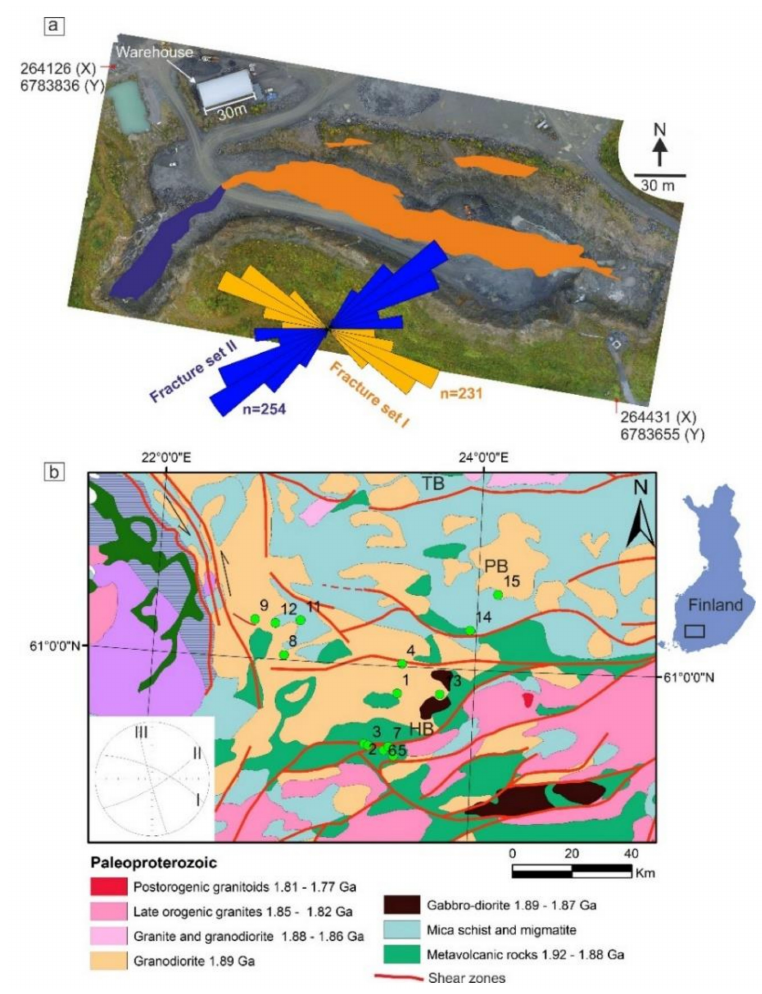
Figure 8. ( a ) Surface resource model of the open-pit mine showing a good match with the strikes of fracture sets I and II. ( b ) Map showing the regional pattern of major shear zones (after [27,30]) and locations of various gold deposits and prospects in SW Finland: (1) Kedonojankulma, (2) Kivenkorva W, (3) Kivenkorva E, (4) Kokkojoki, 5) Riukka, (6) Satulinmäki, (7) Sukula, (8) Uunimäki, (9) Jokisivu, (10) Korvenmaa, (11) Palokallio, (12) Ritakallio, (13) Liesjärvi, (14) Hopeavuori, (15)